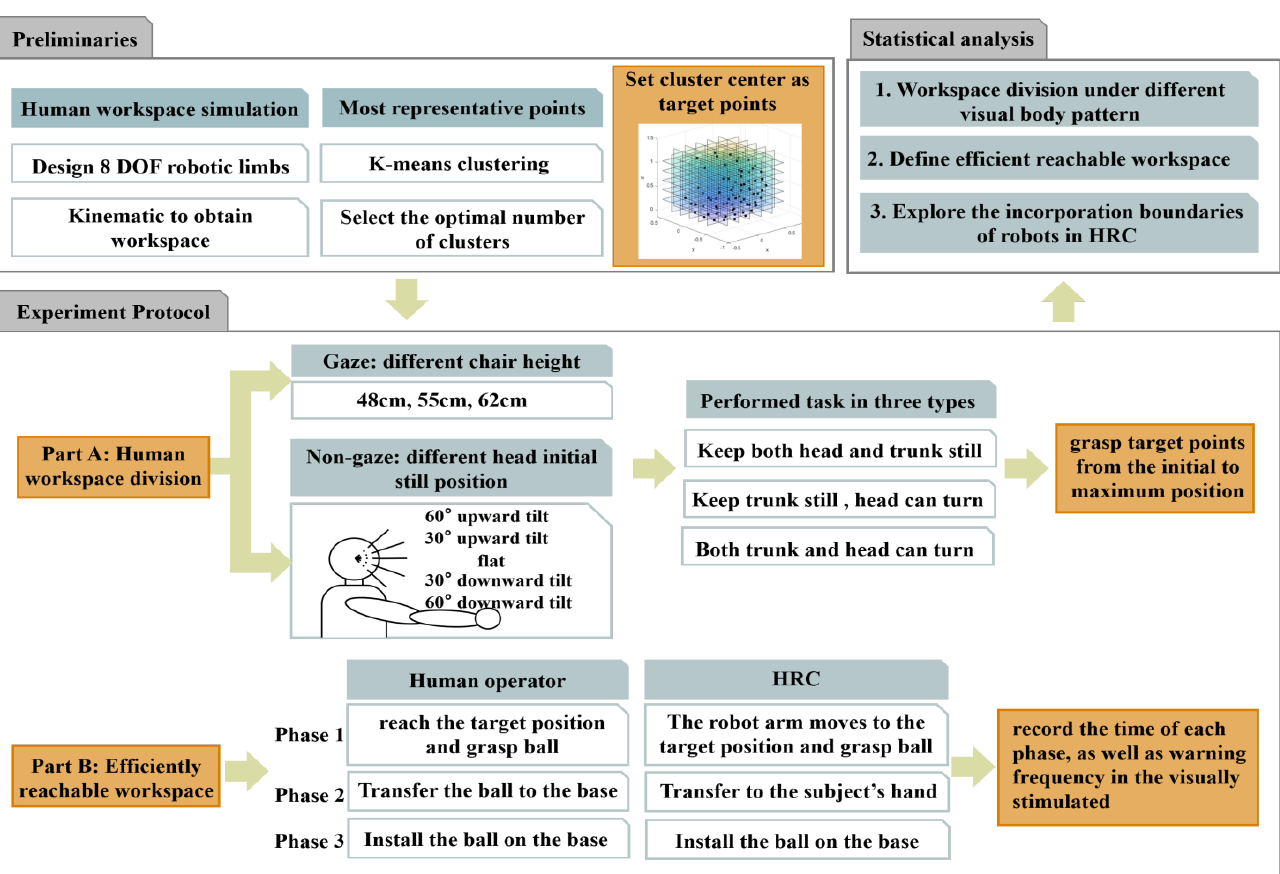
Figure A2. Overall process framework for experiments and data analysis.